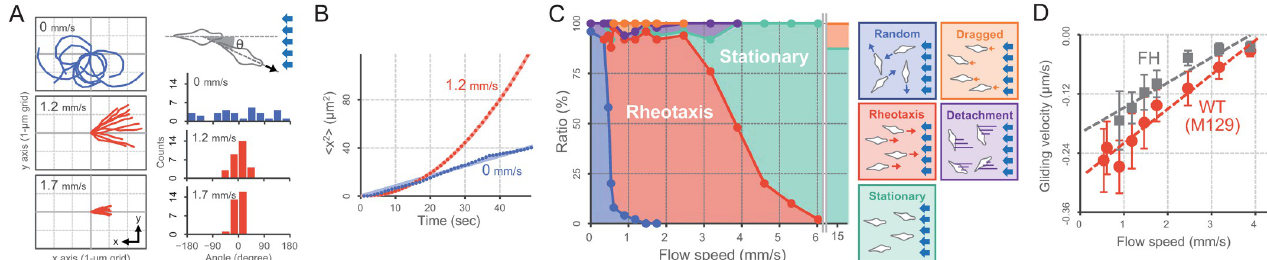
Fig 2. Effect of flow speed on gliding motility of M . pneumoniae . (A) Left : Moving traces of cells at flow speeds of 0, 1.2, and 1.7 mm/s. The traces for 10 s from 10 cells are overlayed. The cell position at time 0 is plotted at the center of the graph. Right : Distribution of the angle between moving direction and the flow axis ( N = 30), which is schematically illustrated at the top. The cell moving against the fluid flow was defined as the zero angle. (B) MSD plots. The time course of mean square displacement (MSD) from 30 cells along the flow direction is plotted. Red : Flow speed at 1.2 mm/s. Blue : No fluid flow. Red and blue lines represent hyperbolic and liner fitting, respectively. (C) Fraction of cell motility pattern. The motility pattern under various flow speeds was categorized into five groups, as presented on the left. (D) Relationship between cell gliding velocity and flow speed. The average and standard deviation (SD) of cell gliding velocity during positive rheotaxis were plotted at each flow speed. Red: Type 1 strain M129 as standard in this study ( N = 30). Gray: Type 2 strain FH ( N = 15). Dashed lines present linear approximations.